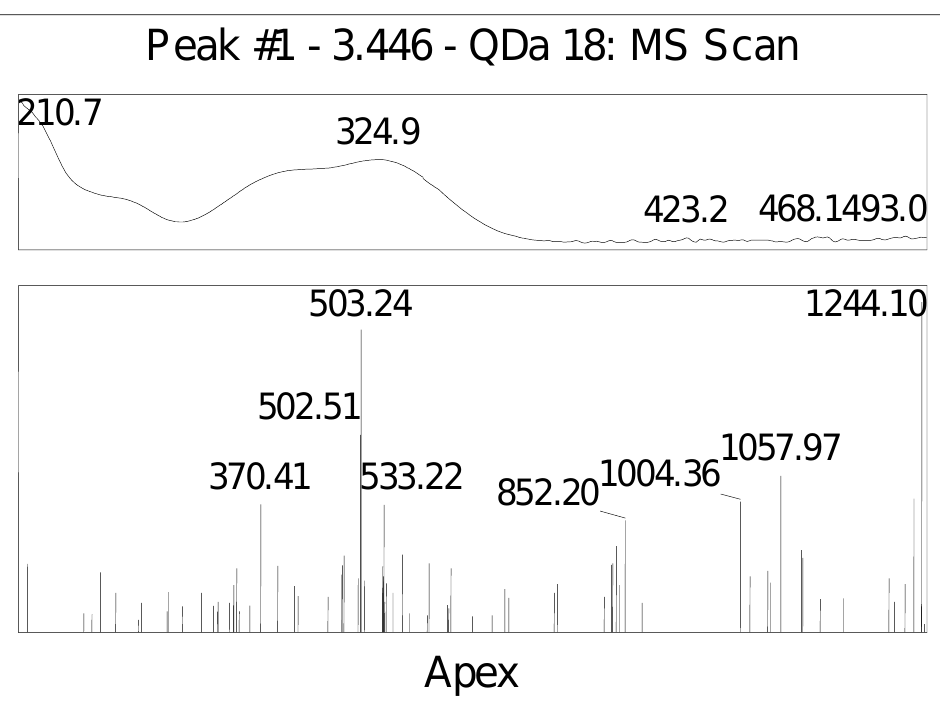
Figure 1. MS scan ESI-MS m/z: 503 [M+H] + The substance 1 - (Figure 1) is retention time 3.446 min, ʎ max324 nm (Table 2); In positive ionization mode, substance 1 mainly showed molecular ions ESI-MS m/z: 503.2 [M +Na]+; according to the obtained results and compounds mass database METLIN ( https://metlin.scripps.edu ) the substance 1 was identified as 20- Hydroxyecdysone (Ecdysterone) [9-11].